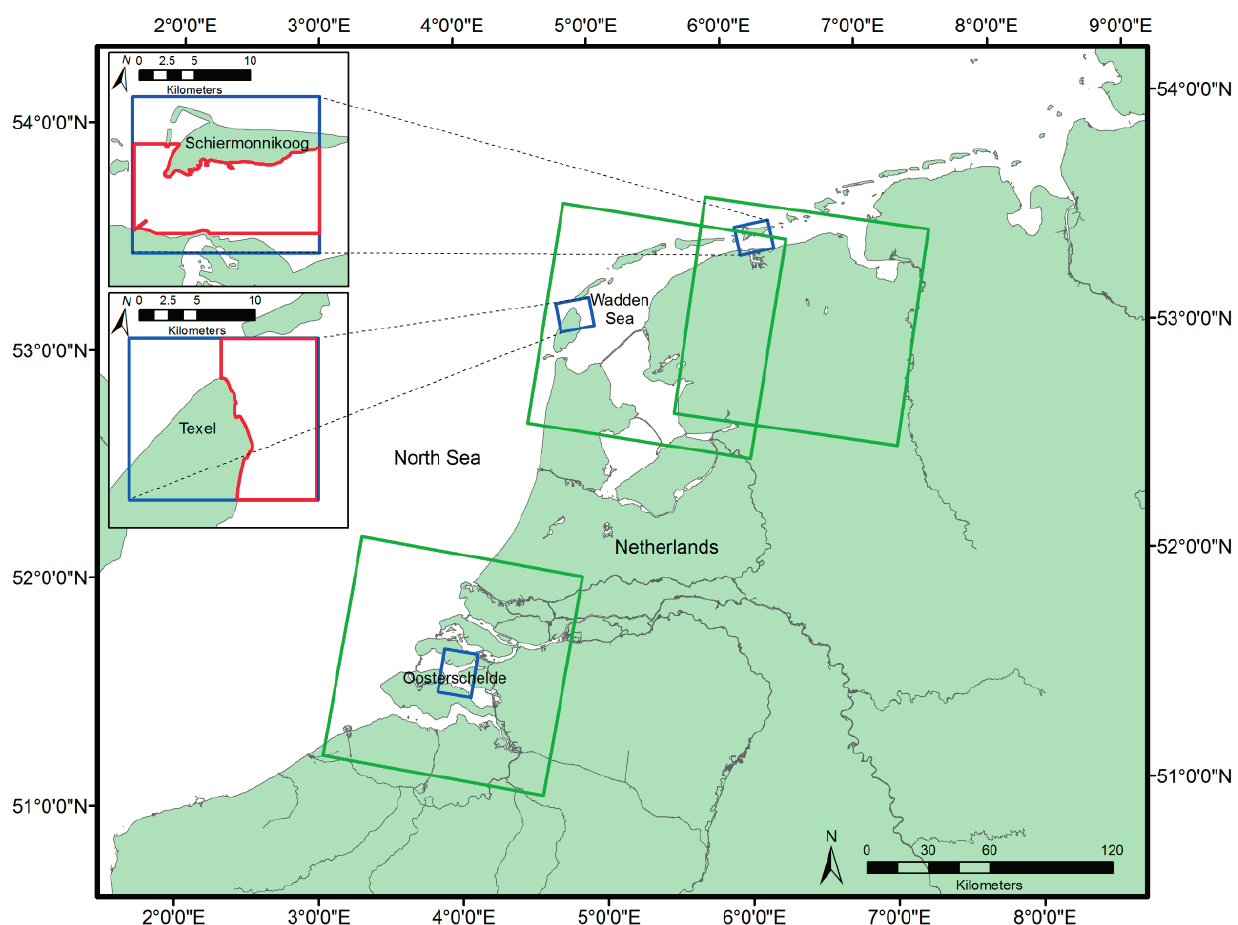
Figure 1. Image acquisitions by Radarsat-2 (green) and by TerraSAR-X (blue) in the Netherlands. The red lines indicate the areas used to compare remotely-sensed and Trilateral Monitoring and Assessment Program (TMAP) shellfish